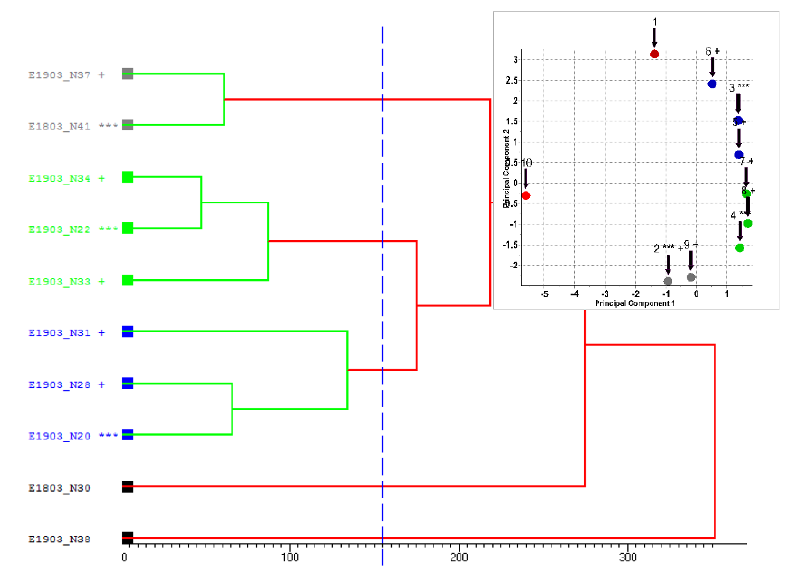
Figure 5. Hierarchical cluster analysis dendrogram obtained on the basis of the IR whole-profile method (multipl whole-profile variables, 10 samples, and principal component analysis plot